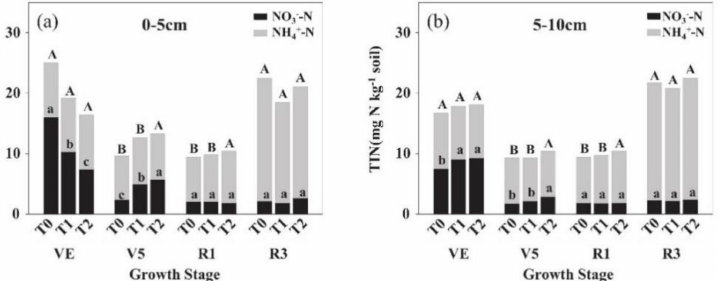
Figure 3. Total inorganic nitrogen (TIN) under three different residue placement treatments (T0, none; T1, surface; T2, incorporated) in 0–5 cm ( a ) and 5–10 cm ( b ) soil layers at four growth stages during maize-growing season in the pot experiment. Mean value ( n = 4) is shown. Different upper − case letters at the same growth stage indicate statistically significant differences in TIN content at p < 0.05 among treatments, and different lower-case letters at the same growth stage indicate statistically significant differences in NO 3 − content at p < 0.05 among treatments.